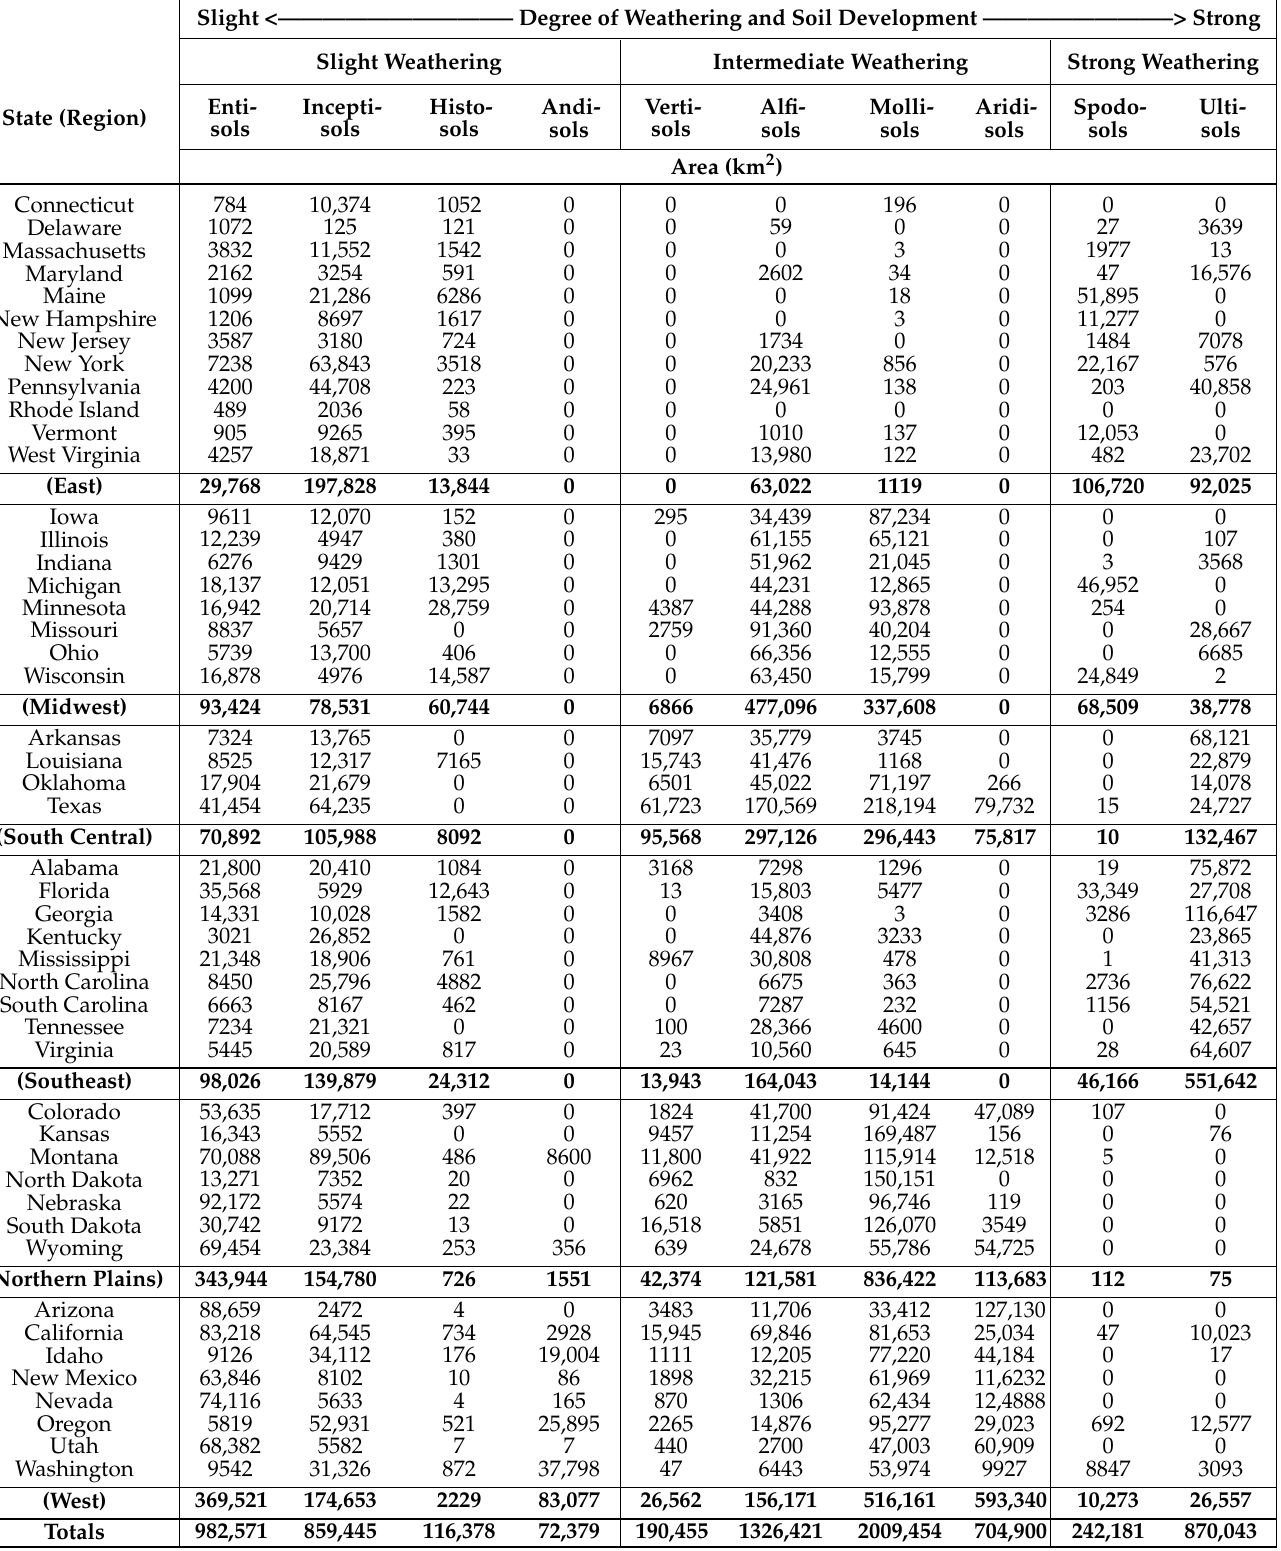
Table 11. Soil diversity (pedodiversity) by soil order (taxonomic pedodiversity) in the contiguous United States (U.S.) based on Soil Survey Geographic (SSURGO) Database (2020) [27]. Slight <——————————– Degree of Weathering and Soil Development ————————–>